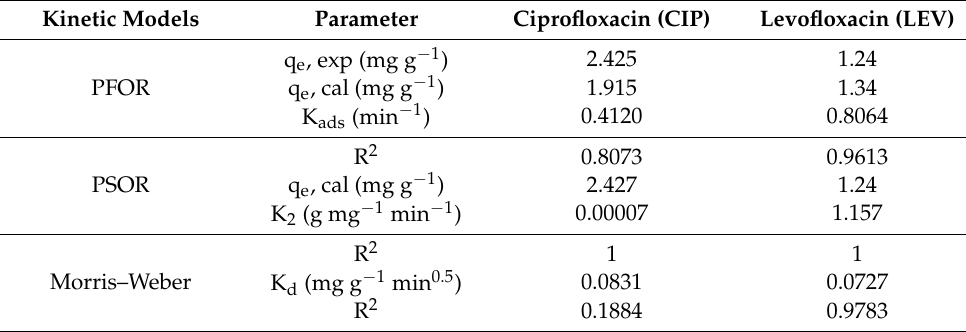
Table 3. Kinetic modeling with the PFOR, PSOR and Morris–Weber equations. Kinetic